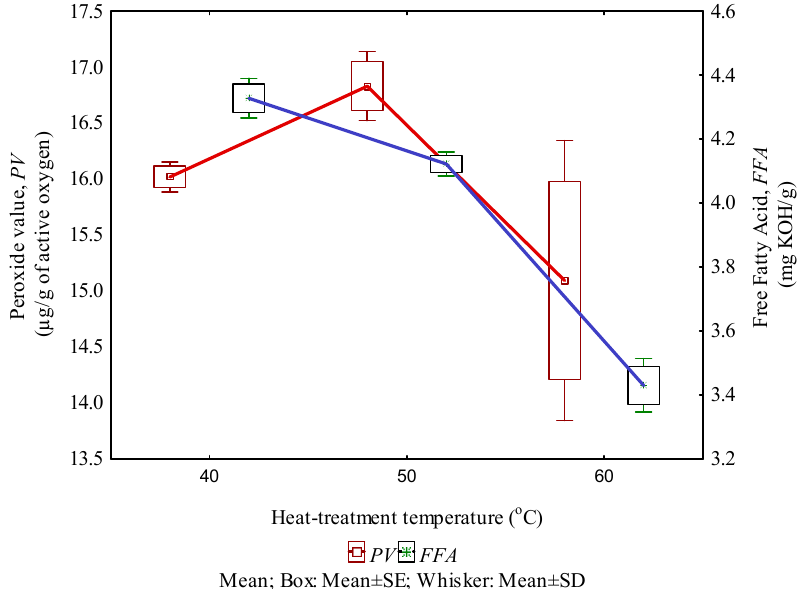
Figure 5. Box plot of peroxide value and free fatty acid of hazelnut kernel oil under heat treatment temperature.